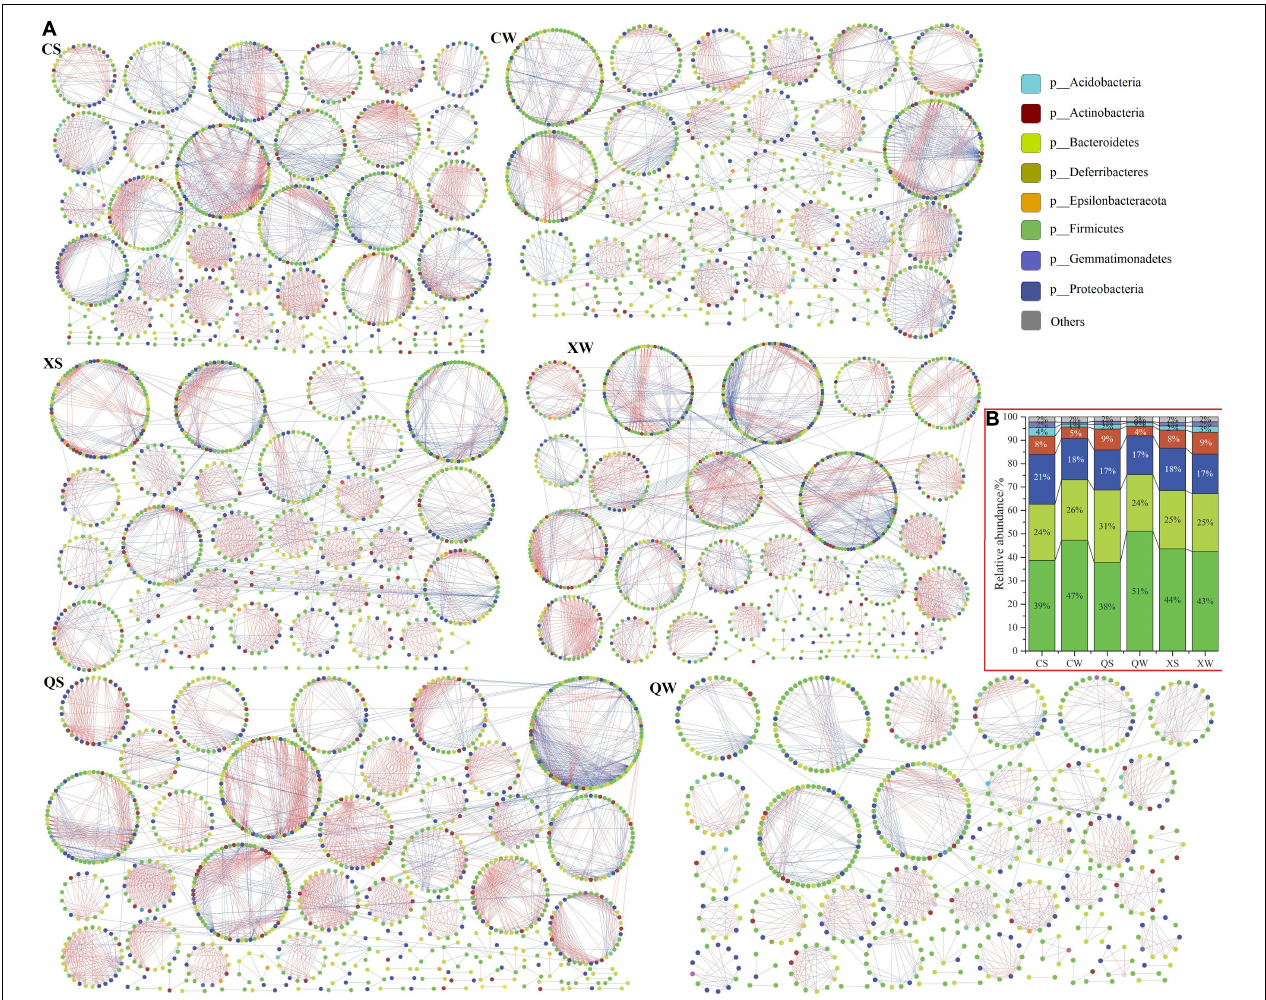
FIGURE 6 | Ecological networks of the intestinal microbiota in the six groups of Nibea albiflora male, female, and all-female fish during an investigation of the composition of their intestinal microbiota (A) . Ecological network graph with submodule structure was obtained using the fast-greedy modularity optimization method. Each node indicated one OTU at the phylum level. Node colors indicated different major phyla. Blue edges indicated a positive interaction between two individual nodes, while red edges indicated a negative interaction. Main component in the six networks at the phylum level (B) . X, C, and Q represented male, female, and all-female fish, respectively. Two seasons: summer (S) and winter